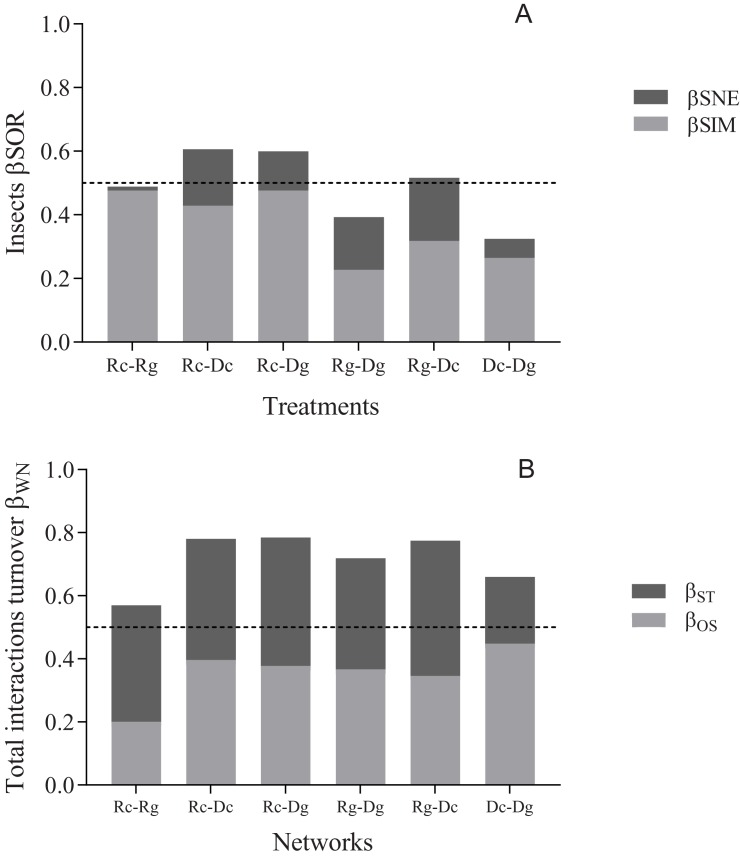
Beta diversity of cerambycids.Turnover of species and interactions (β-diversity) among treatments: Rain canopy (Rc), Rain ground (Rg), Dry canopy (Dc) and Dry ground (Dg) in a tropical dry forest. A) Sorensen dissimilarity of species (βsor) and its components of turnover (βsim) and nestedness (βsne). B) Dissimilarity of interactions and its components (βST, dissimilarity in the interactions due to the similarity of the composition of species), and (βOS, similarity of interactions in species that co-occur; i.e., species rewiring).